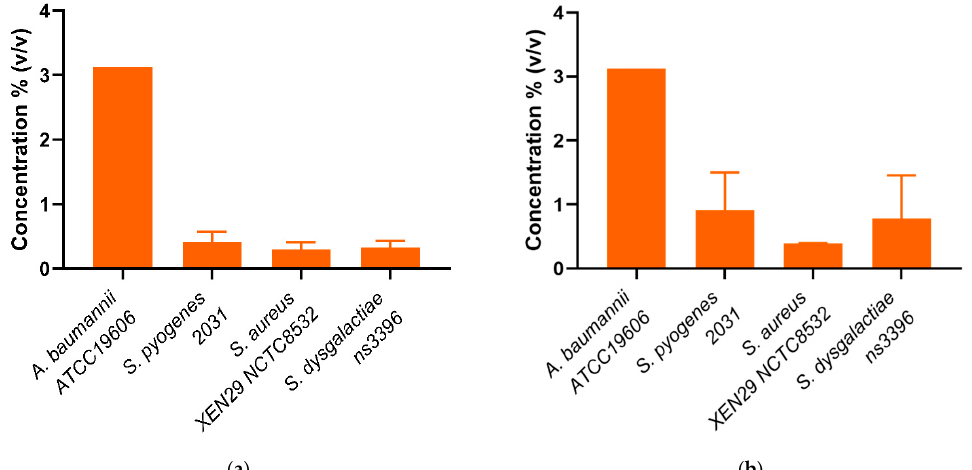
Figure 2. ( a ) Minimum inhibitory concentrations (MIC) and ( b ) Minimum bactericidal concentrations (MBC) of m ā nuka oil (% v / v ) against four scabies-associated bacteria.